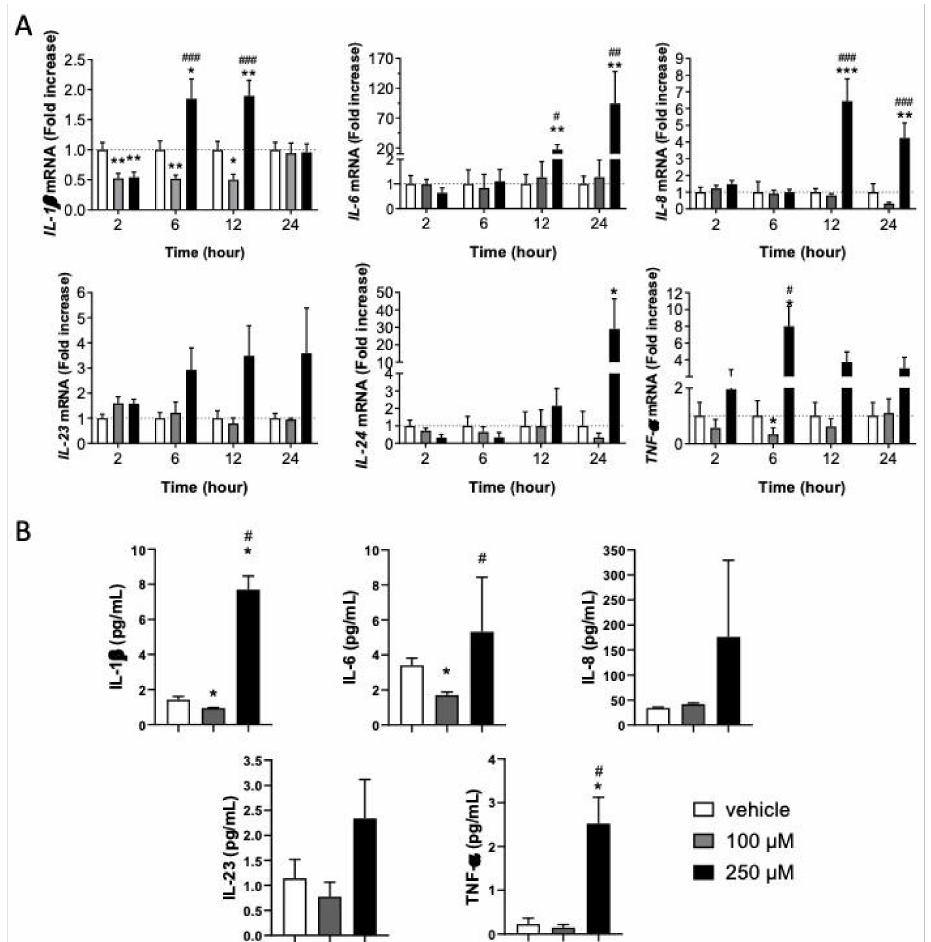
Figure 2. KC’s inflammatory response is dependent on the CinA concentration. KCs were exposed to 100 µ M or 250 µ M of CinA from 2 to 24 h. ( A ) The mRNA level of inflammatory cytokines IL-1 β , IL-6, IL-8, IL23, IL-24, and TNF- α determined by RT-qPCR after 2–24 h of exposure to 100 and 250 µ M of CinA and DMSO 0.1% as the vehicle control. ( B ) The inflammatory cytokines level was determined by Meso Scaled Discovery technology in the supernatant of KERTr after 24 h of exposure to 100 and 250 µ M of CinA. Data represent the results of 3–14 independent experiments and are expressed as the mean ± SEM. ( A , B ) * Represents the statistical difference between CinA and vehicle-treated cells, and # represents the statistical difference between 100 µ M and 250 µ M-treated cells. *, # p -value < 0.05, **, ## p -value < 0.01, and ***, ### p -value < 0.001 (Mann–Whitney test). Compared to untreated KC, the lower CinA concentration (100 µ M)